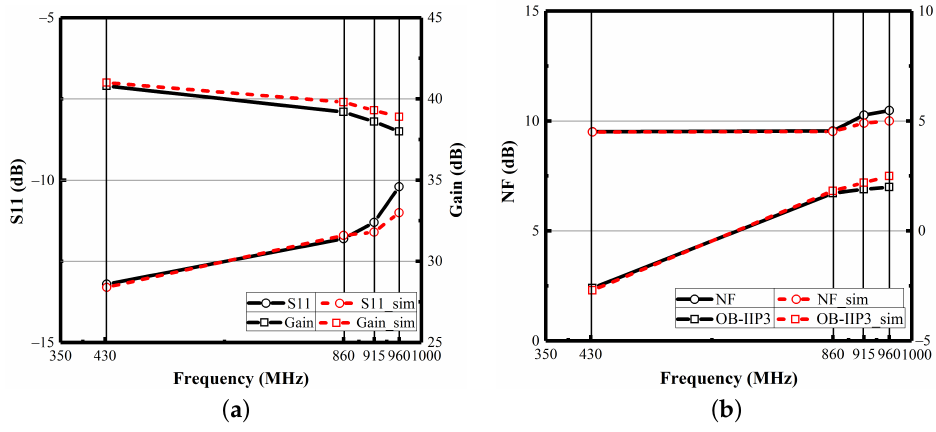
Figure 12. Simulated and measured performance ( a ) S11 and Gain. ( b ) NF and